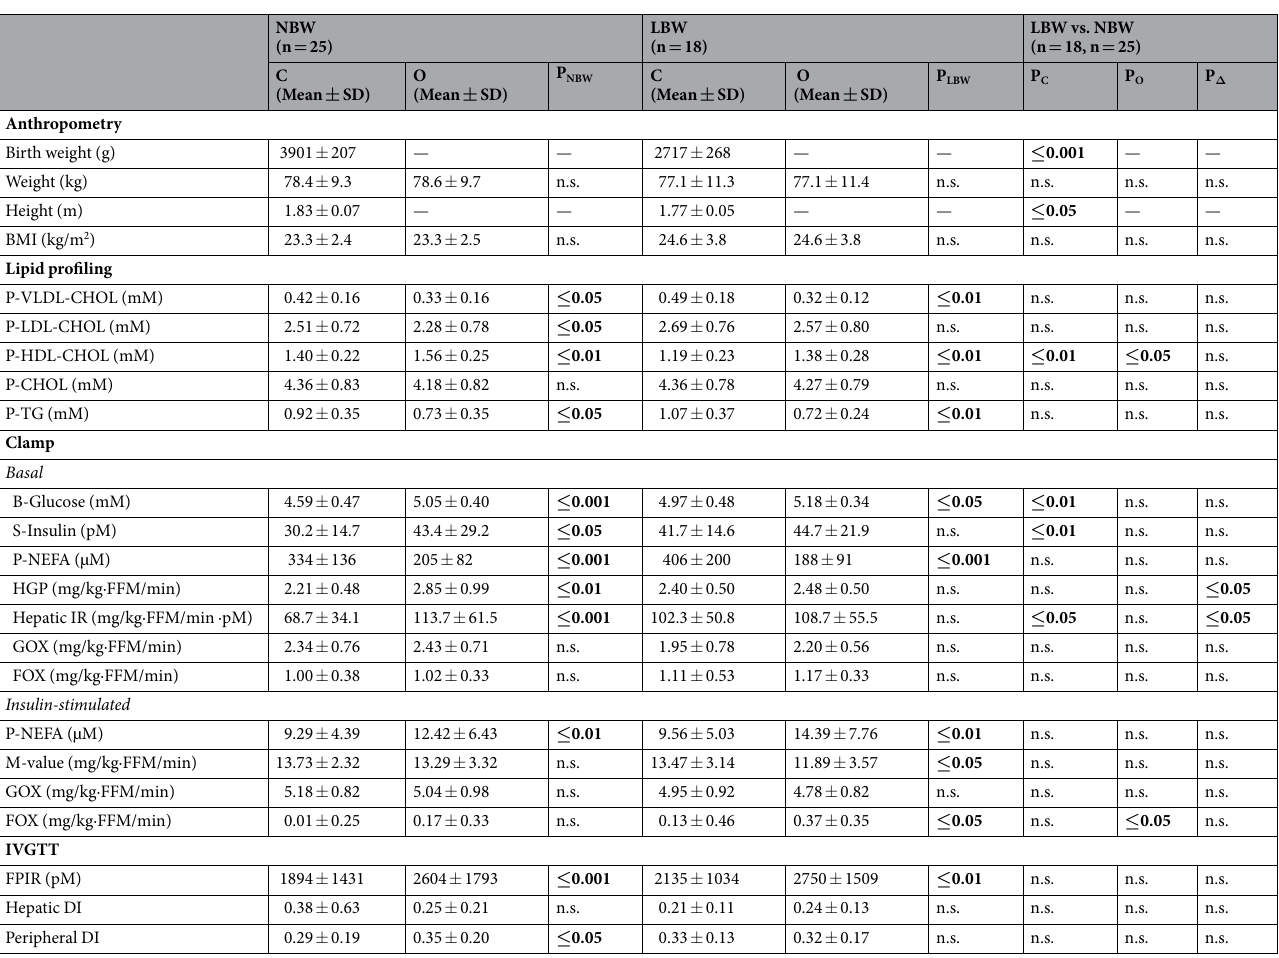
Table 1. Clinical characteristics of low (LBW) and normal birth weight (NBW) men following the control (C) and high-fat, high-calorie (O) diets. Data are presented as mean values ± standard deviations (SD). P-values are presented unadjusted for multiple comparisons, and P-values ≤ 0.05 are considered statistically significant. P NBW and P LBW : O vs. C diet within each birth weight group, P C and P O : LBW vs. NBW men within each diet, P Δ : LBW vs. NBW men on response values. P-values ≤ 0.05 are marked in bold. n.s.: Not significant. Other